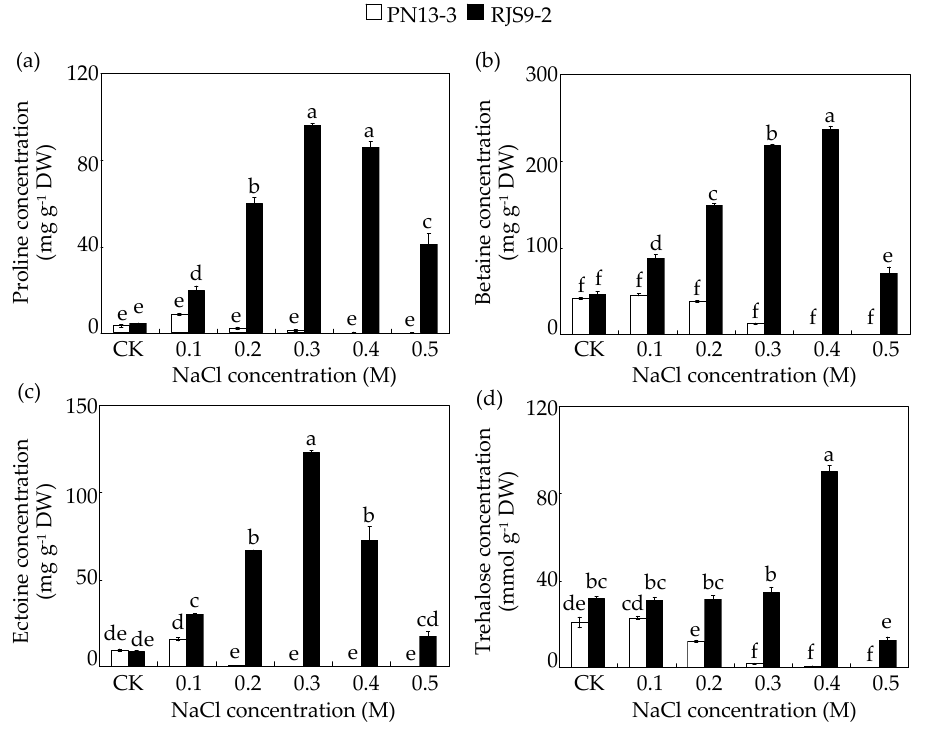
Figure 4. Osmoprotectant concentrations in two Bradyrhizobium strains at various NaCl levels. ( a ) Proline concentrations; ( b ) Betaine concentrations; ( c ) Ectoine concentrations; ( d ) Trehalose concentrations. Bradyrhizobium strains were separately inoculated into liquid medium containing 0.0017 (CK), 0.1, 0.2, 0.3, 0.4, or 0.5 M NaCl and further incubated at 28 °C and 180 rpm. The osmoprotectant concentrations in the bacteria were detected after 8 days of NaCl treatment. A column represents mean value obtained from four biological replicates and bar represents standard error. An individual flask was considered one biological replicate. The same letter indicates no significant difference at p < 0.05 (Duncan’s test).